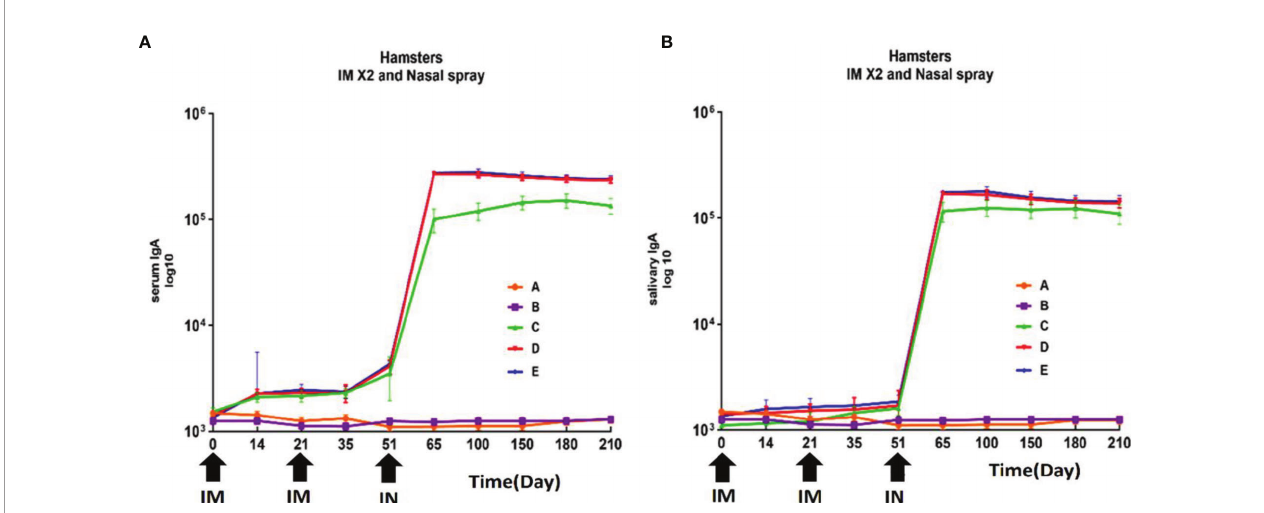
FIGURE 5 | Anti-SARS-CoV-2 immunoglobulin-A (IgA) antibody titers against RBD in hamster immunized with candidate vaccine. All vaccinated animals receiving two intramuscular (IM) and one intranasal (IN) of candidate vaccine at 3-week intervals (days 0, 21 and 51). (A) Anti-SARS-CoV-2 immunoglobulin-A (IgA) antibody titers against RBD in serum of hamster for 210 days from the day it is received candidate vaccine; The increased IgA antibody of serum against RBD was signi fi cantly higher in animals receiving different doses of candidate vaccine until day 210 (P<0.001). (B) Anti-SARS-CoV-2 immunoglobulin-A (IgA) antibody titers against RBD in salivary of hamster for 210 days from the day it is received candidate vaccine. The results of IgA analysis in saliva showed a signi fi cant increase in IgA antibody level after the third dose of the candidate vaccine (IN) in hamsters (P<0.001). P values lower that 0.05 were considered to be statistically signi fi cant. Data are presented as mean ± SD. The levels of statistical signi fi cance for differences between test groups were determined using one-way ANOVA followed by Tukey ’ s post hoc test. Statistical comparison was done by comparing the vaccinated group with the placebo group as a control. Placebo (adjutant of RAS-01) (group A),